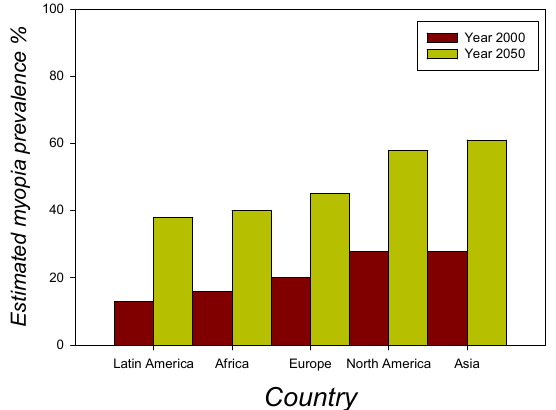
Figure 3. Estimated increase in myopia prevalence in populations from di ff erent countries of the world including Asia between the years 2000 and 2050 [3]. The percentages shown here are based on data from an earlier report published five years ago. Current statistics from a more recent review [2] reveal that in 2019, only 5% of the total populations of East and Southeast Asia still had normal (uncorrected) vision. This leads one to suggest that higher percentages than shown above are to be anticipated for the year 2050 if nothing gets done to stop the worldwide trend of